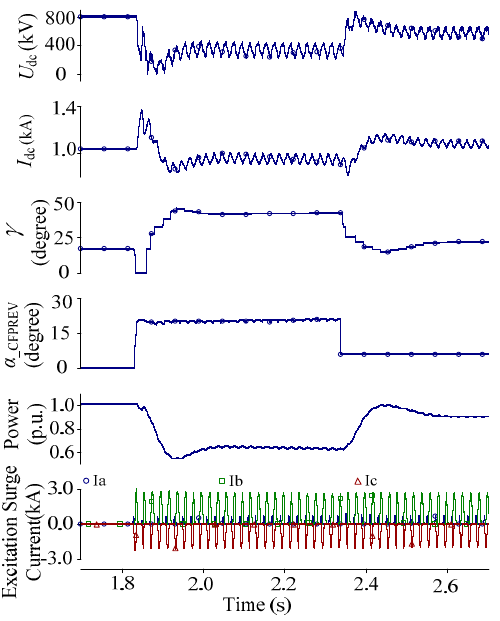
Figure 14. Reproduction of the disturbance due to a 1000 kV UHV AC transformer excitation current and the proposed commutation failure prediction algorithm.